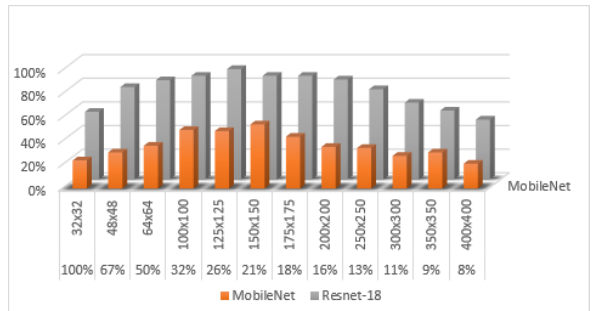
Figure 8. The Top-1 classification rate of test images from the CERUG-CN dataset for both Resnet-18 and MobileNet models with several sizes of the original